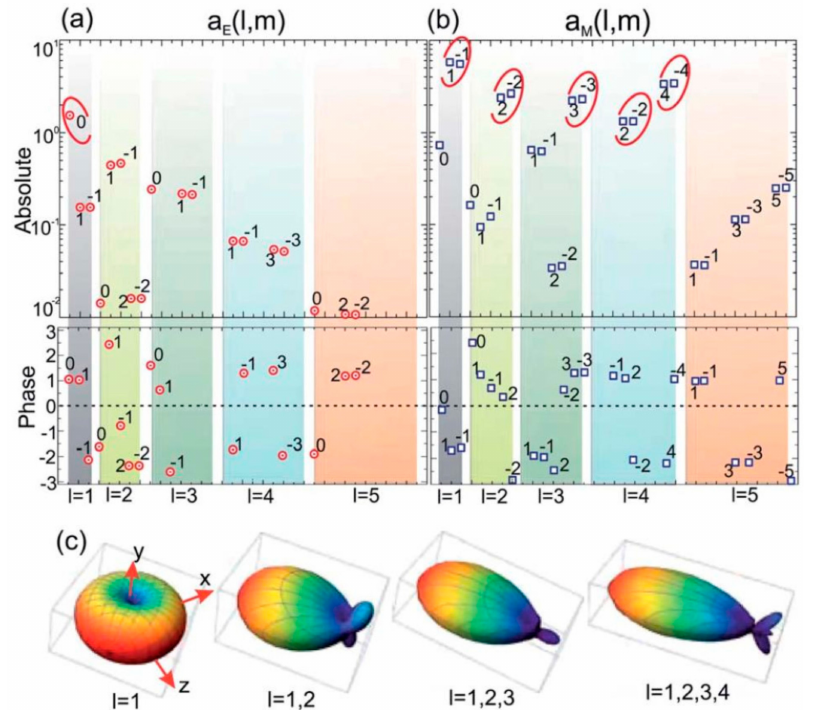
Figure 5. Magnitude (upper row) and phase (lower row) of the most contributing ( a ) electric and ( b ) magnetic multipole moments. Multipole coe ffi cients providing the largest contribution to the antenna directivity are highlighted by red circles. ( c ) Dependence of the radiation pattern of dielectric superdirective antenna on the number of considered multipoles (the dipole source is oriented along the z -axis). Reprinted with permission from